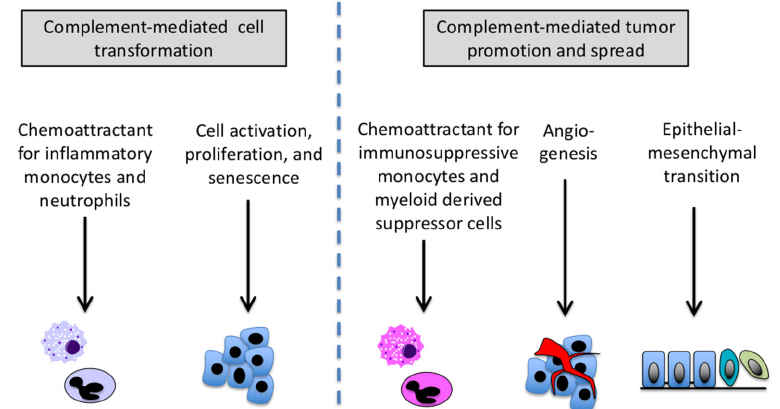
Figure 1. Possible roles for complement in tumor initiation and promotion. Complement activation